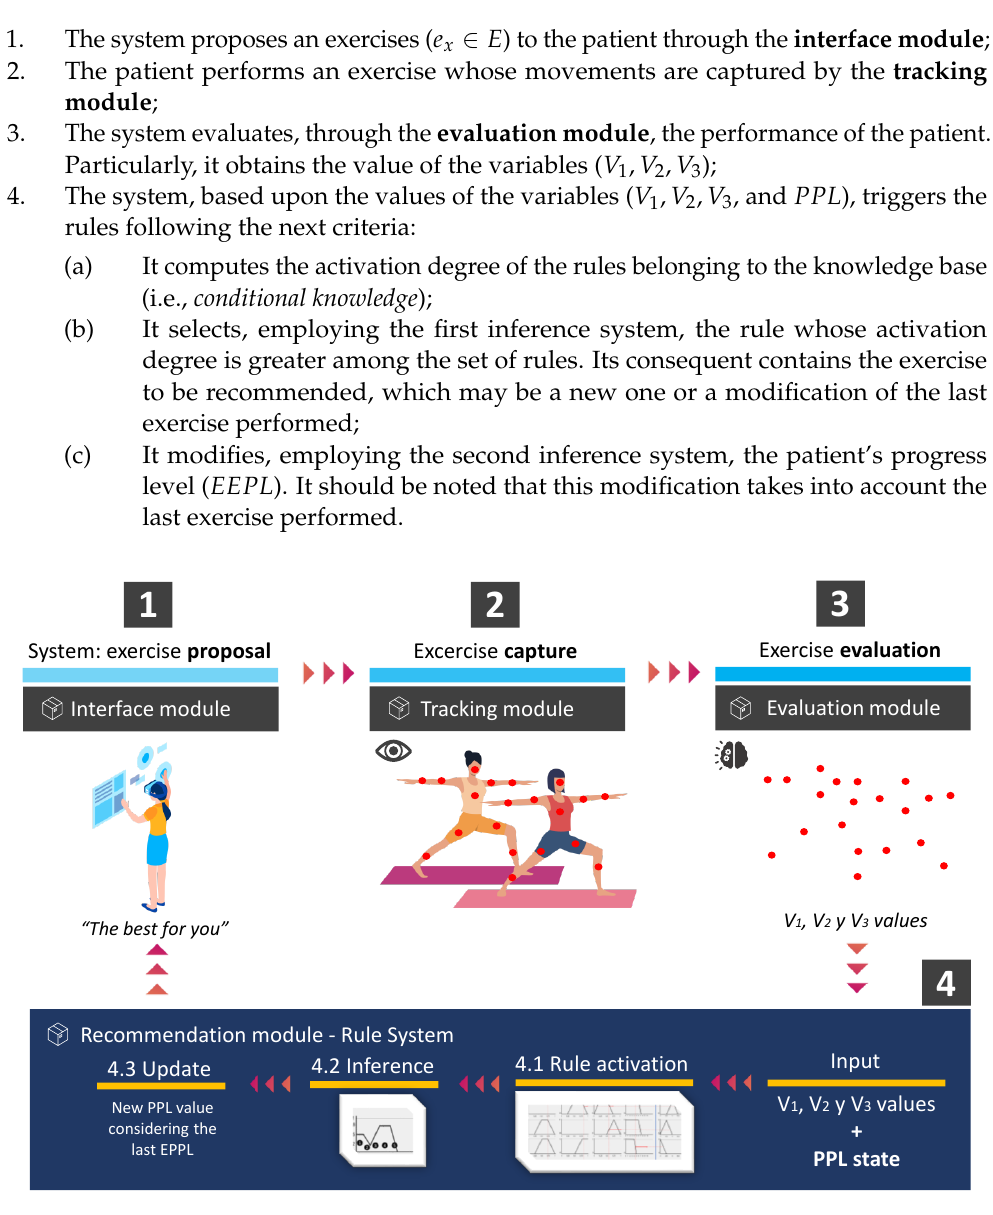
Figure 6. Holistic view of the recommender system. Consider a stroke patient whose mobility on the left side of the body has been substan- tially reduced. Fortunately, the patient’s progress has relatively improved over the past few sessions. Imagine that the last exercises performed consisted in, from an upright bipedal posture, raising the left arm from the hip to the shoulder, passing the hand in red color through the spheres placed in the 3D world that draw a trajectory. Fundamentally, the hand must pass first through the sphere close to the hip and with the largest size, ending the repetition when the colored joint reaches the sphere close to the shoulder and with the smallest size. This exercise comprises three repetitions and it must be completed under two minutes. Figure 7 graphically shows the left shoulder abduction by means of a virtual system in which the patient simulates the movement, so that their left hand touches the colored